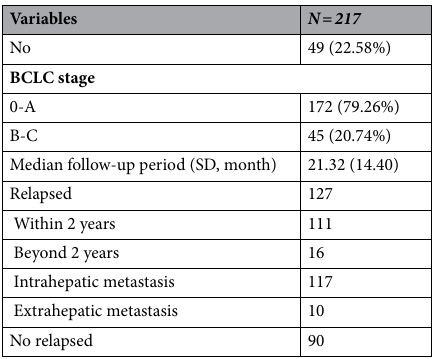
Table 1. The clinicopathological variables in patients with HCC (n = 217). WBC white blood cell, PLT platelet, ALT alanine transaminase, AST aspartate trasaminase, PT prothrombin time, APTT activated partial